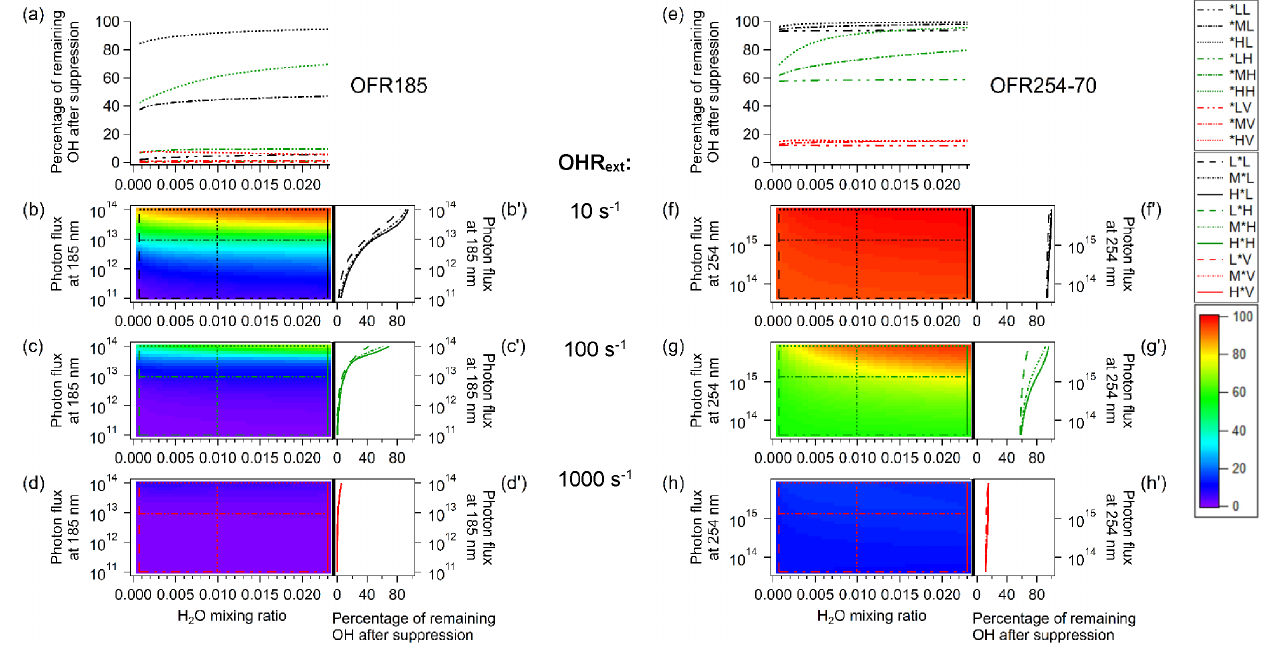
Figure 5. Percentage of remaining OH after suppression vs. the same parameters and in the same format Fig. 2, but without the case of no external OH reactivity, which is the reference